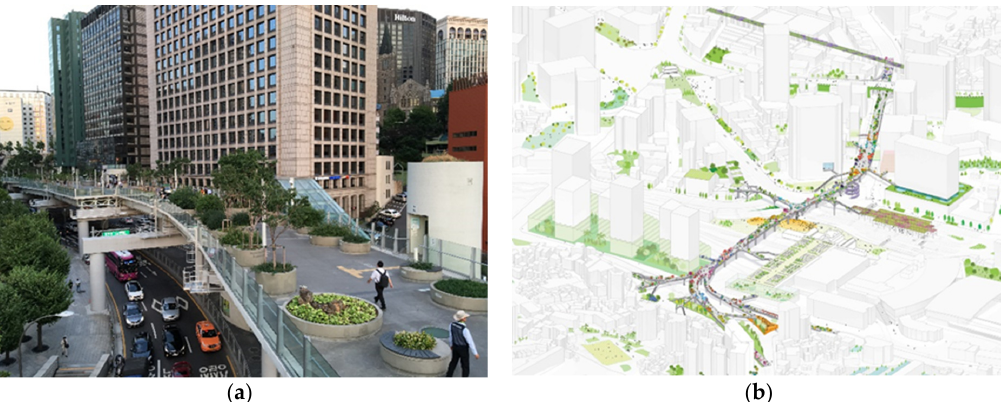
Figure 10. The Seoullo project: ( a ) current view; ( b ) Seoul Arboretum—a perspective of the original design (source: ( a ) author’s photograph; ( b ) MVRDV, [68]).